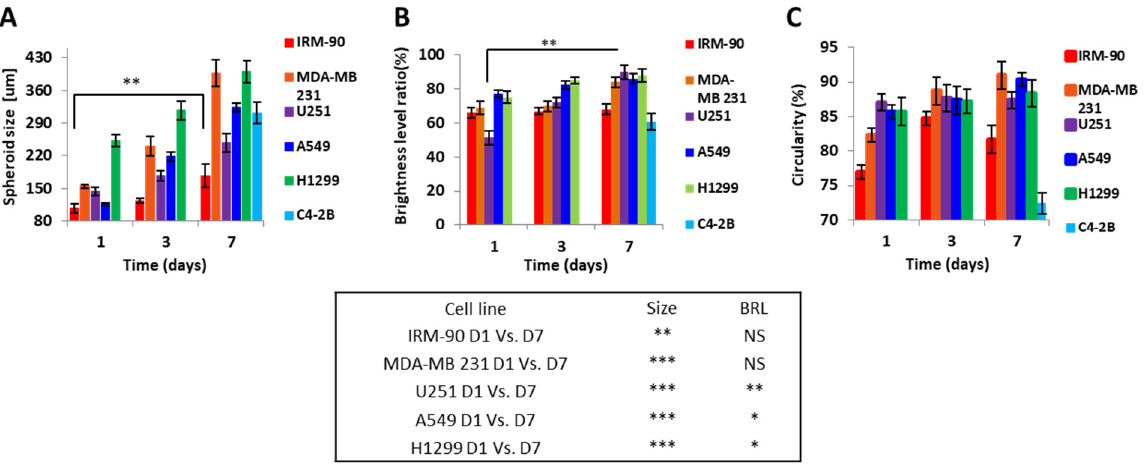
Figure 4. Proliferation and growth pattern for spheroid production on biochip pre-coated with 10% BSA. ( A ) Spheroid size over the seven days of culture. Spheroid size varied and was significantly increased on day 7 compared to day 1 for all cell lines (D1 vs. D7 ** p < 0.001 and *** p < 0.0001). C4-2B cell line was only able to produce spheroid after day 3 of culture, and we accordingly only saw the size on day 7. ( B ) BRL for U251, A549, and H1299 significantly increased on day 7 compared to day 1 (D1 vs. D7 * p < 0.05 and ** p < 0.001) and for IRM-90 and MDA-MB 231 varied non-significantly (NS = non-significant). ( C ) Circularity is representative of the spherical or circular shape of spheroids. Circularity increased non-significantly on day 7 compared to day 1 for all of the cell lines. C4-2B cell line only was able to produce spheroid after day 3 of culture, as previously mentioned. All assays were performed as triplicates per trial in three independent experiments. (Error bars represent ± SE, n =